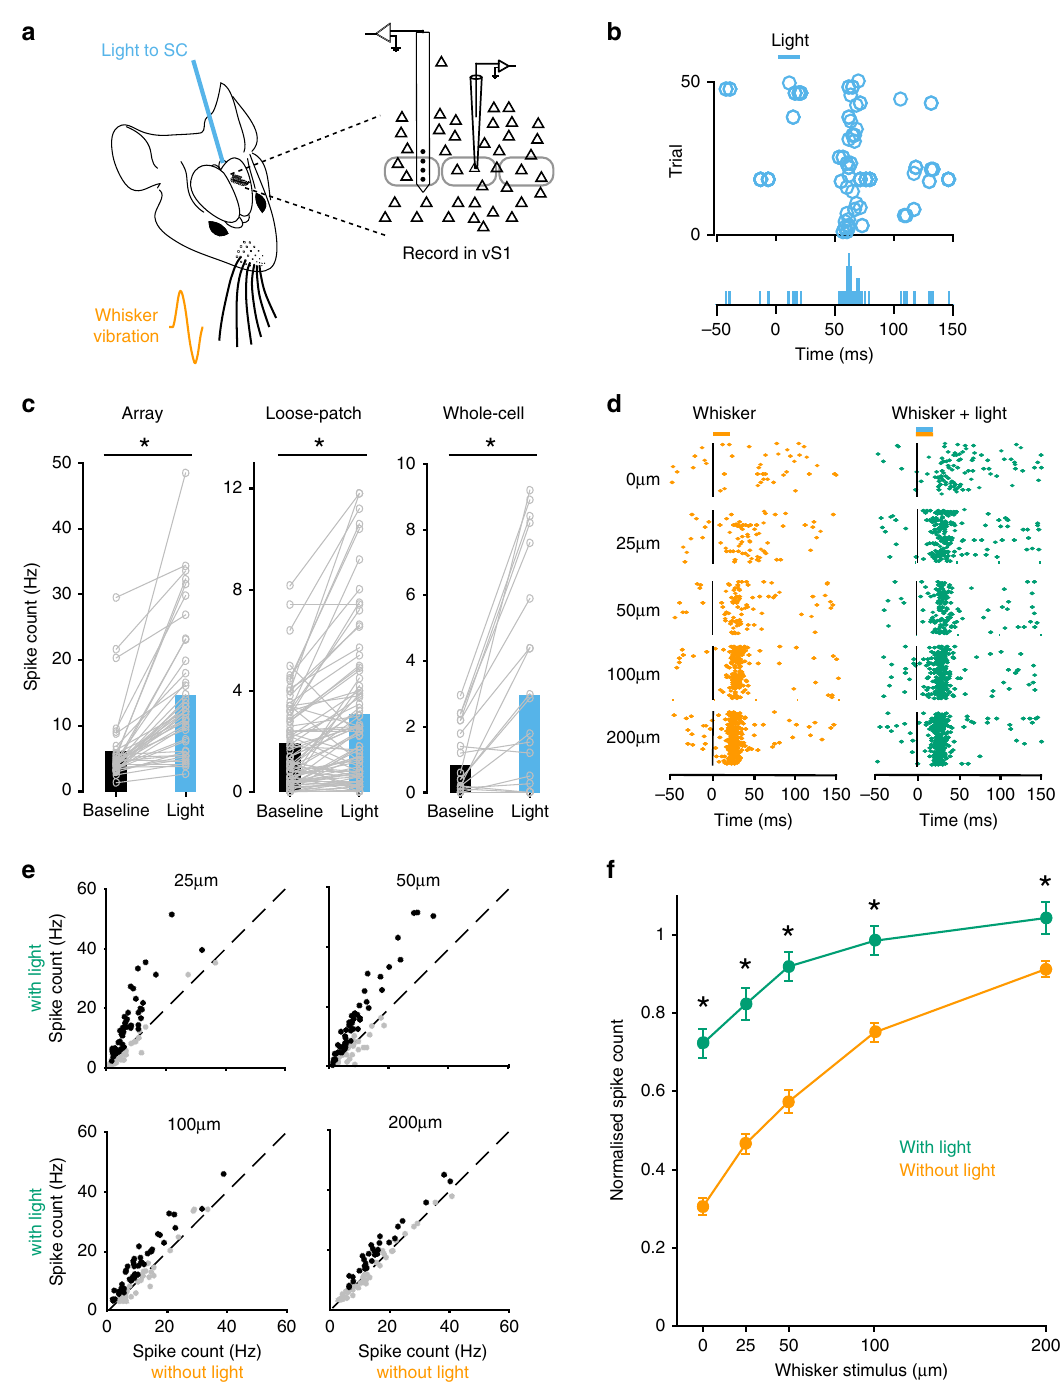
Fig. 2 Optogenetic activation of SC modulates vS1. a Schematic of the experimental arrangement. Recordings were made from the vS1 while activating SC optogenetically via an optic fi ber in the presence or absence of whisker vibration. b Raster plot (top) and peri-stimulus time histogram (bottom) during loose-patch recording from a neuron in vS1 (513 µ m from the surface of the brain) showing increased spiking during SC stimulation. c Spiking of vS1 neurons increase signi fi cantly during light activation of SC (extracellular array recordings: n = 41; loose-patch recordings: n = 85; whole-cell recordings: n = 23). Asterisks represent p < 0.001 (Two-sided paired t -test). d Raster plot of action potential fi ring during extracellular recording from a vS1 neuron (589 µ m from the surface of the brain) during whisker movement of different amplitude alone (orange dots; left) and with light activation of SC (green dots; right). e Plot of action potential fi ring in whisker responsive vS1 neurons ( n = 127) with and without light activation of SC during whisker stimulation of different amplitude. Black symbols indicate a signi fi cant increase in fi ring during SC activation ( n = 101; ROC analysis). f Pooled data showing the impact of SC activation (green) on the whisker input – output relationship (orange). Only neurons that were responsive to both whisker and SC stimulation were included in this analysis ( n = 101 neurons). Asterisks represent p < 0.001 (Two-sided paired t -test). The spiking of each neuron was normalized to the maximum response to whisker stimulation alone. Error bars represent SEM. Source data are provided as a Source Data fi